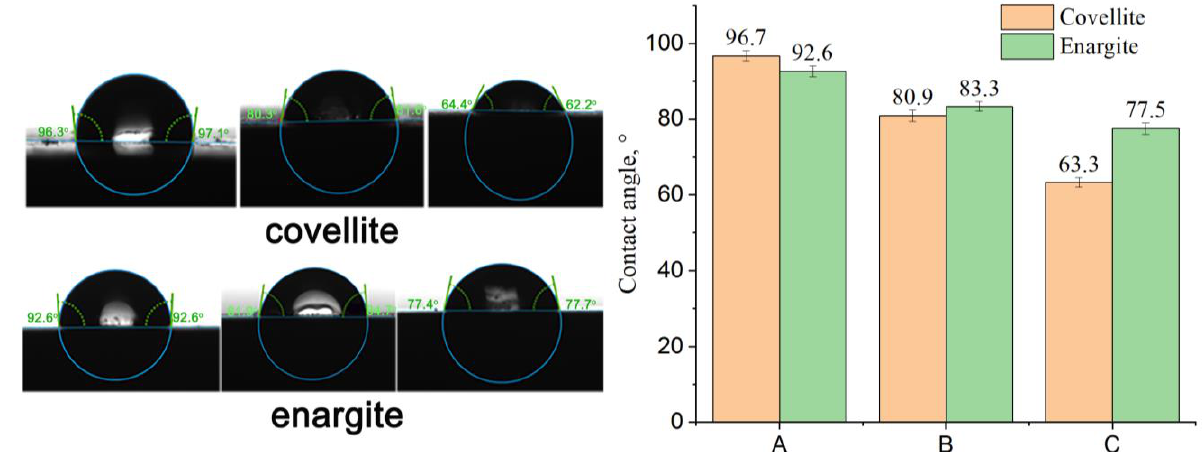
Figure 13. Effect of the different reagents added on the contact angles of covellite and enargite (A: sample + 1 × 10 − 5 mol/L ADD; B: sample + 2 g/L NaClO + 1 × 10 − 5 mol/L ADD; and C: sample + 1.5 g/L NaClO + 0.5 g/L FeCl 3 + 1 × 10 − 5 mol/L ADD).